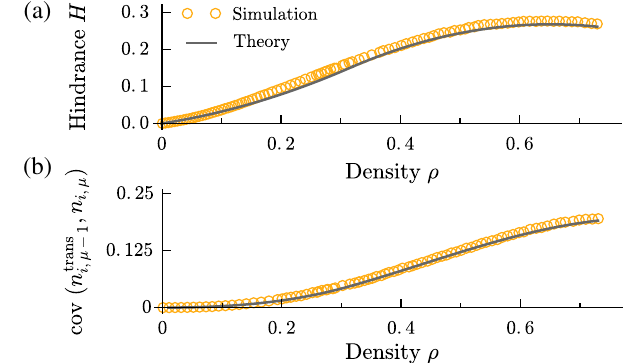
FIG. 5. Current-density relation for different numbers of lanes W with L ¼ 16384 and δ ¼ 1 = 2 . The theory for the current- density relation (dashed lines) agrees very well with simulation data (symbols). Although deviations from the TASEP current- density relation (solid line) increase with a growing number of lanes, the three regimes of the current-density relation are preserved: the low-density regime (positive derivative with respect to ρ ), the high-density regime (negative derivative), and a unique maximum. Note that the theory depends on ρ , which in turn depends on W and δ . For the theoretical max lines, a fit-free approach based on the analytic result for ρ Appendix A) was employed for two lanes. For three and four lanes, results were taken from the simulations to ensure that deviations originate from the theory itself not the estimate of ρ . The particle current refers to an arbitrary lane of the system max in order to allow for a comparison to the TASEP.